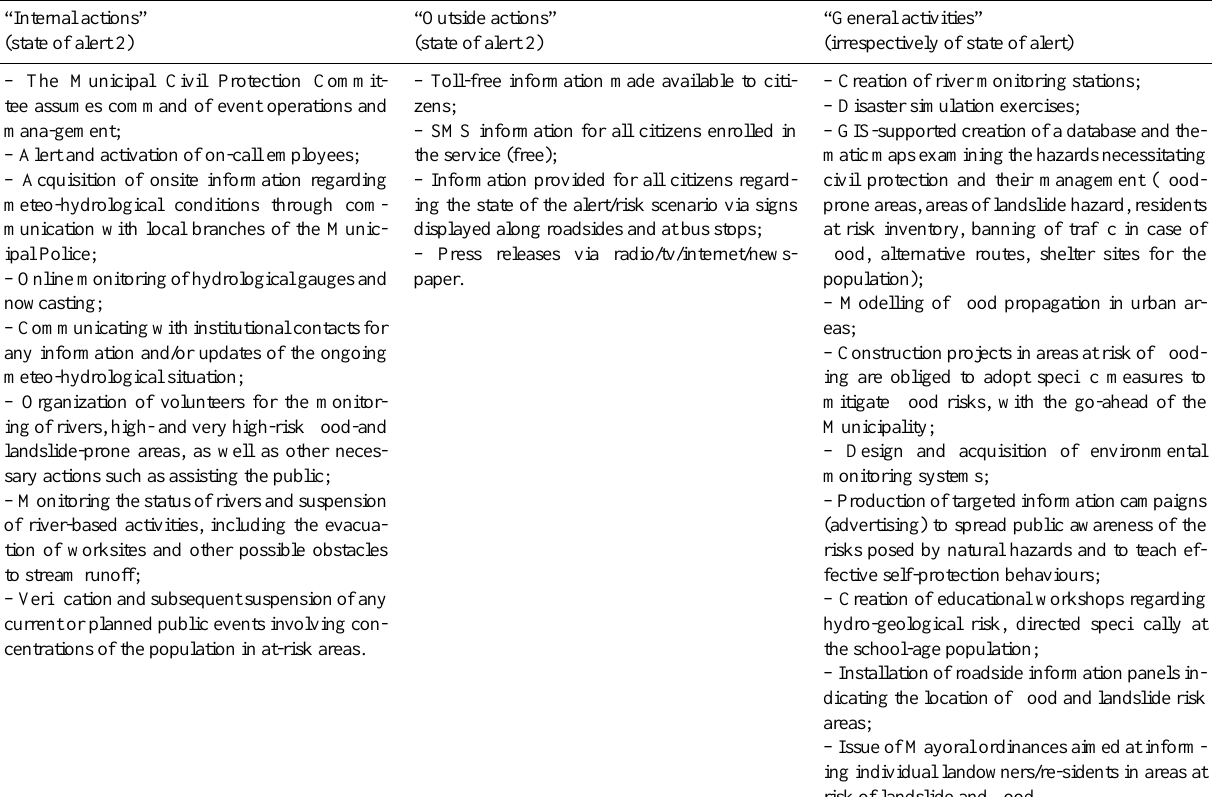
Table 2. “Internal and outside”actions to be undertaken in the case of the most critical alert scenario and “general activities” (from Comune di Genova,